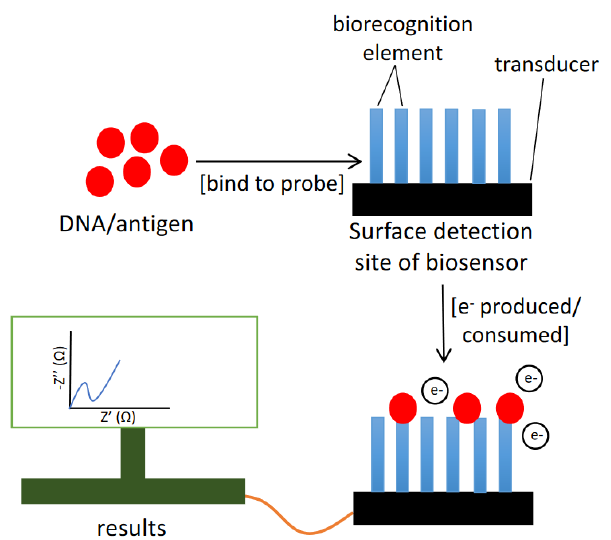
Figure 8. Basic concept of electrochemical biosensor.